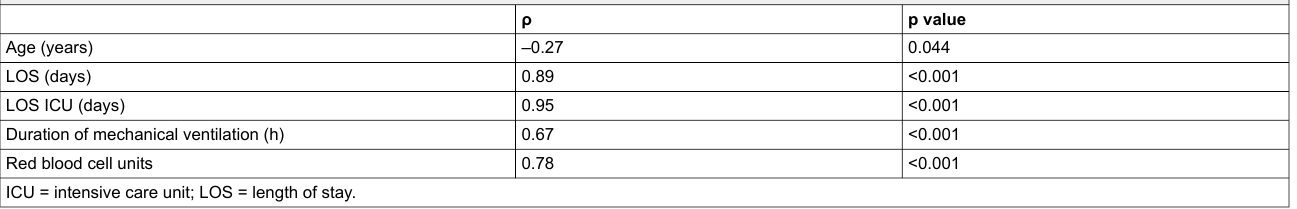
Table S1: Univariate analysis of continuous variables predicting total cost per case for severe burns. Study population: discharges from the University Hospital of Zurich (n = 56). Bivariate correlation determined with Spearman correlation.